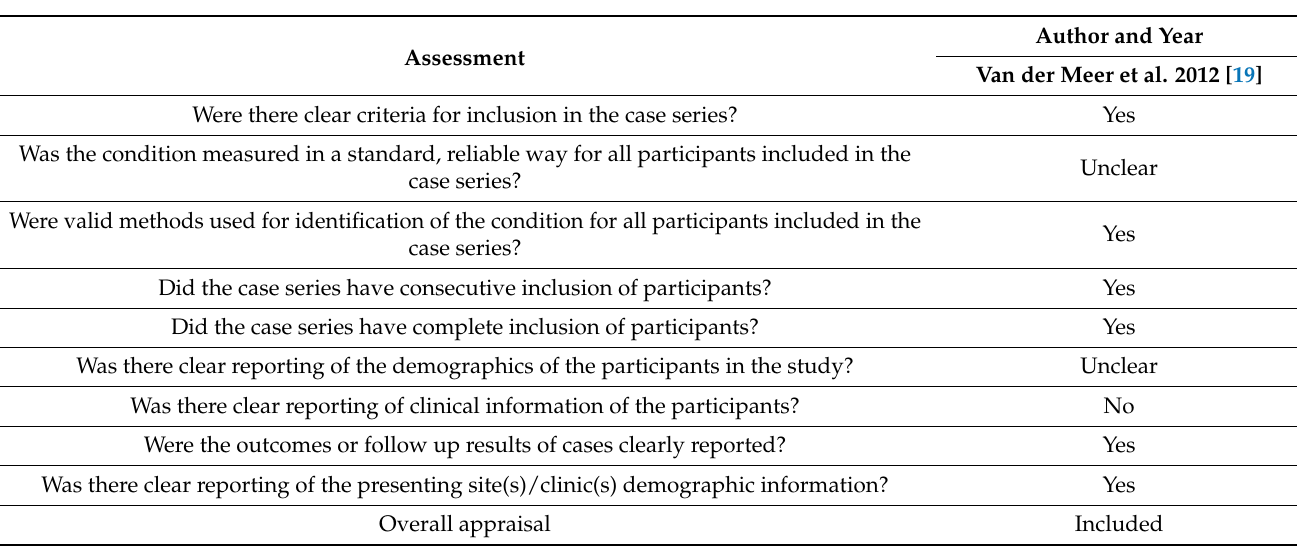
Table 3. Risk of bias for case